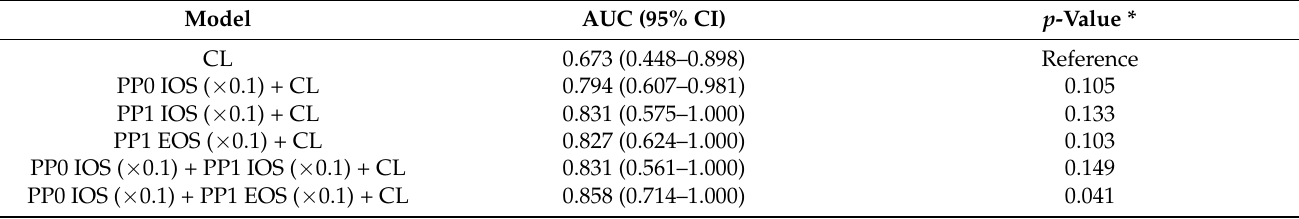
Table 4. Comparison of area under the ROC curve between CL at diagnosis alone and combination models for the prediction of spontaneous preterm delivery at <32 weeks of gestation in women with a short cervix treated with progesterone.